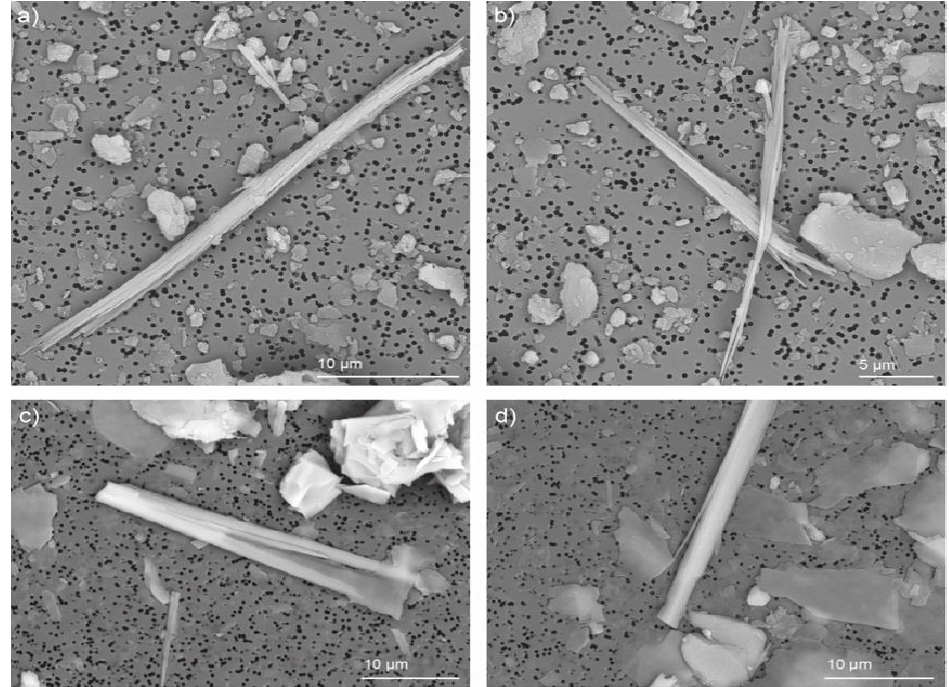
Figure 3. SEM images. Representative asbestiform ( a,b ) and nonasbestiform ( c,d ) amphiboles of the tremolite–actinolite series. Magnifications: 2000×; high vacuum: 20 kV; detector: back-scattered electrons.